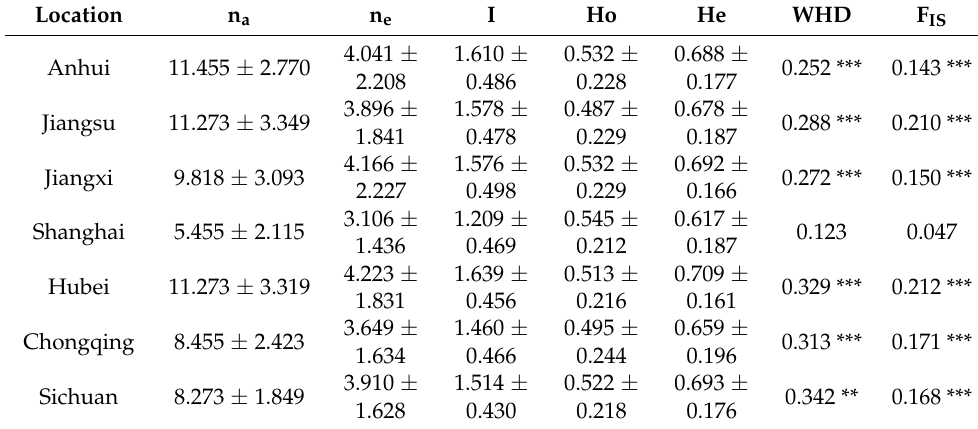
Table 2. Genetic diversity indices of 22 Ae. albopictus populations sampled from seven locations of the Yangtze River Basin based on nine microsatellite loci. Location n a n e